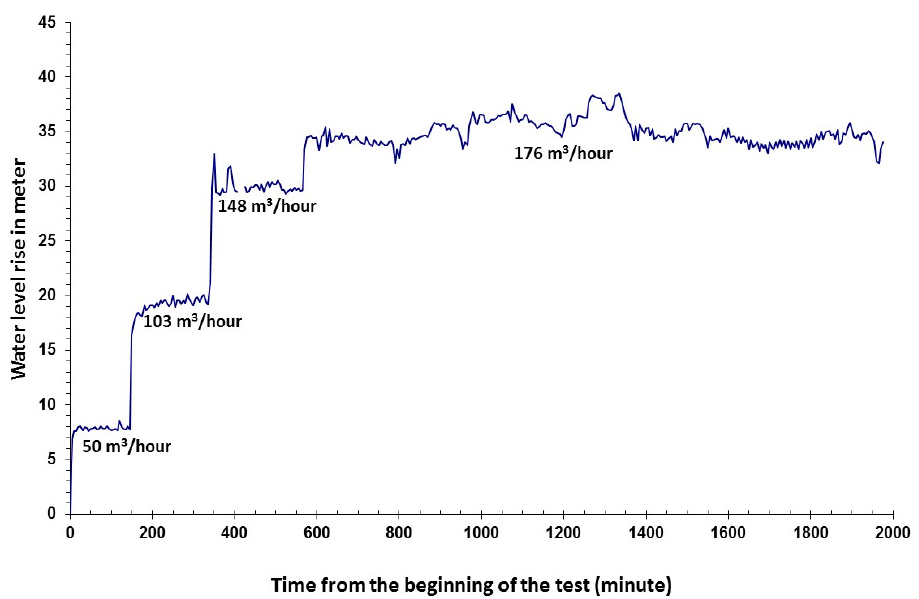
Figure 5. The recharge test in the recharge well.